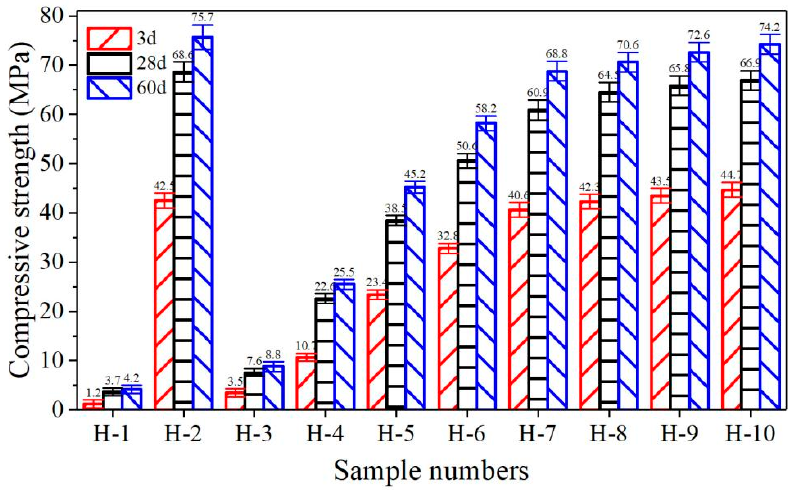
Figure 1. Compressive strength of polymer samples.